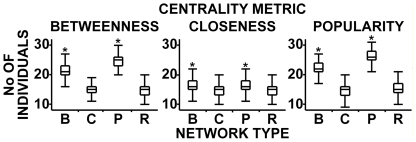
Comparing individuals that successfully maintained increased centrality rank for 7 or more time intervals.B- and P-networks had significantly more such individuals than R-networks for all metrics. C-networks were indistinguishable from the R-networks. Metrics that were significantly different from those in R-networks in multiple comparisons are denoted with *. The box plots indicate descriptive statistics: median, quartiles, maxima and minima.